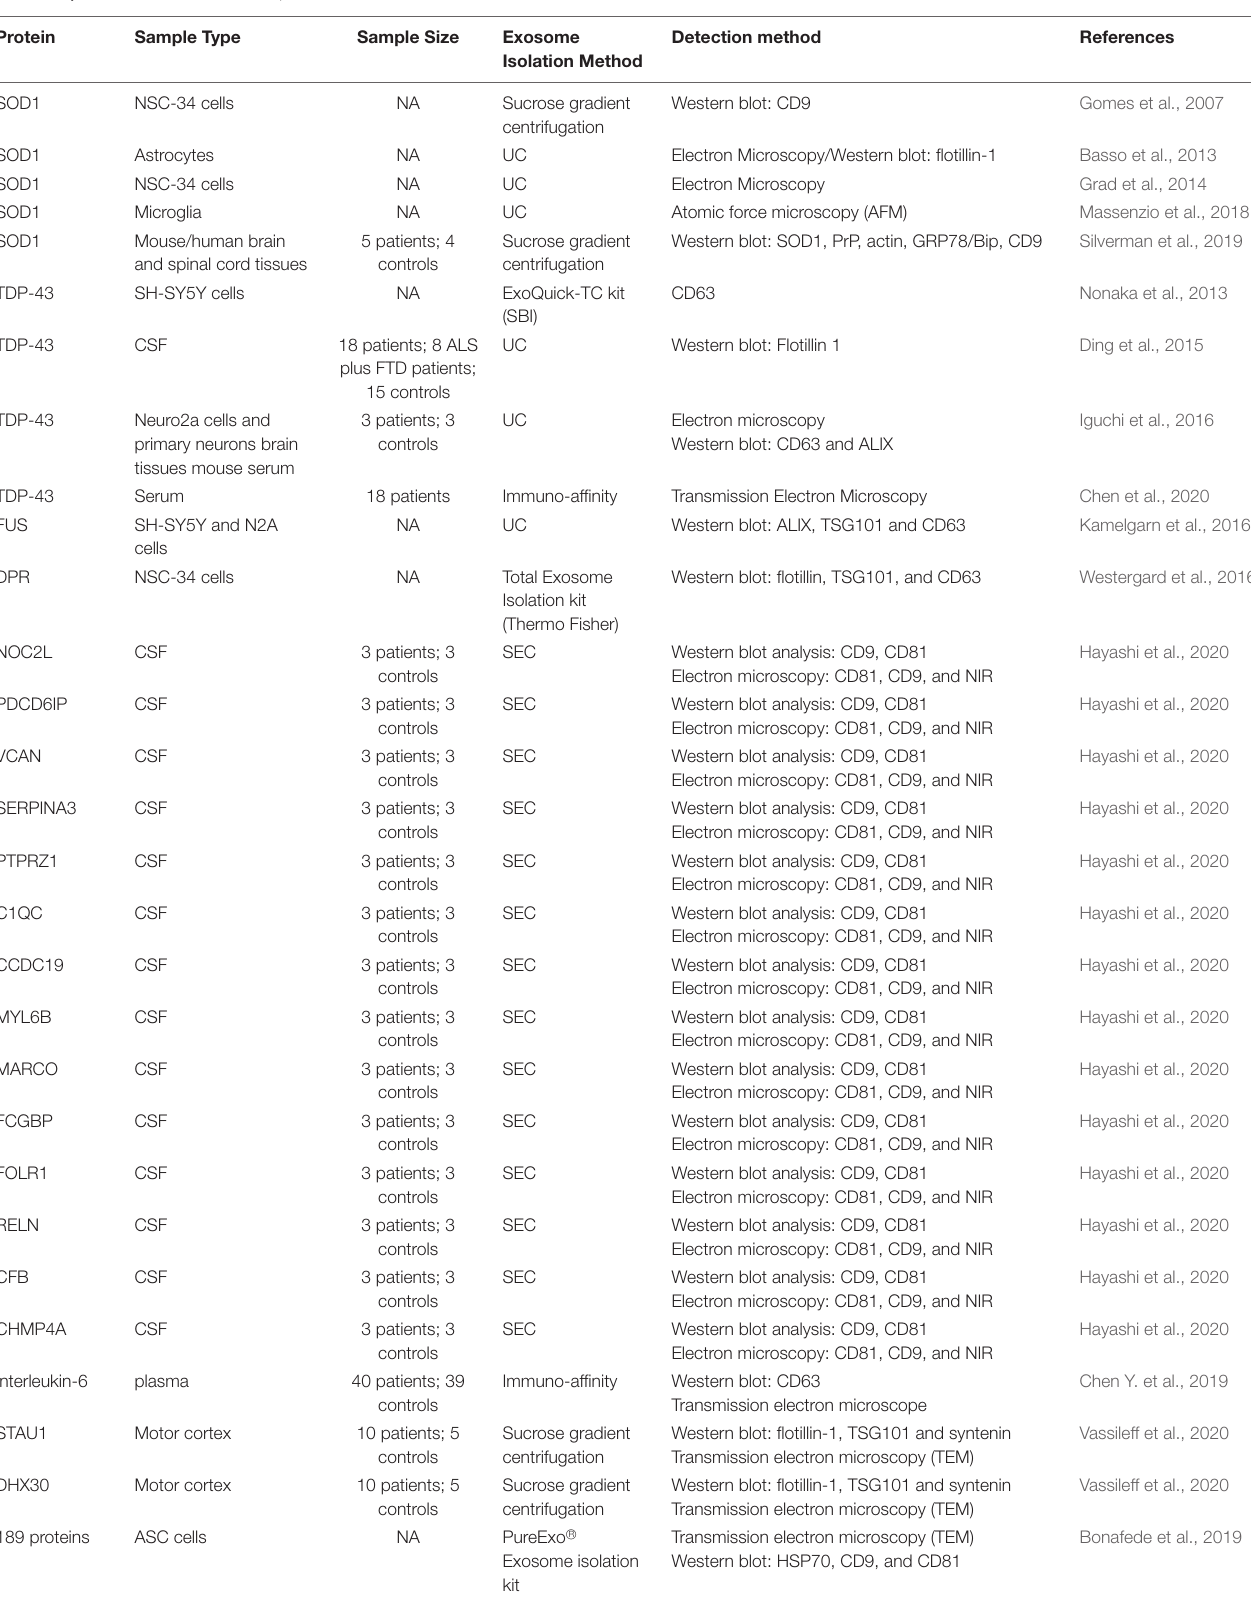
TABLE 2 | Altered levels of exosomal proteins in